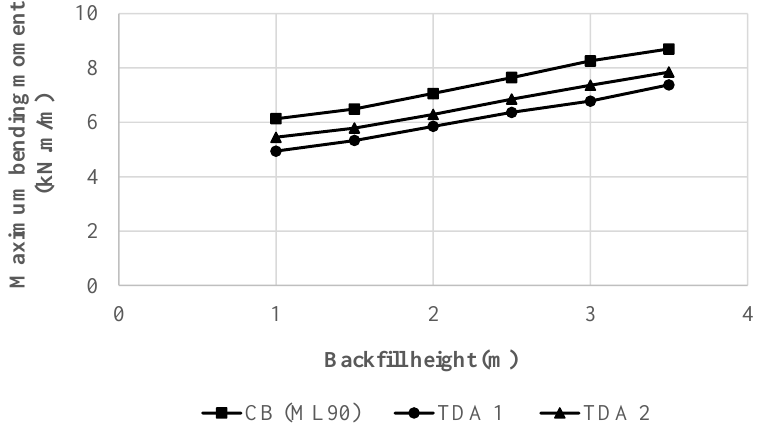
Figure 8. Effect of the backfill height on the maximum bending moment for the three trench config- urations considering the ML90 as a backfill soil.